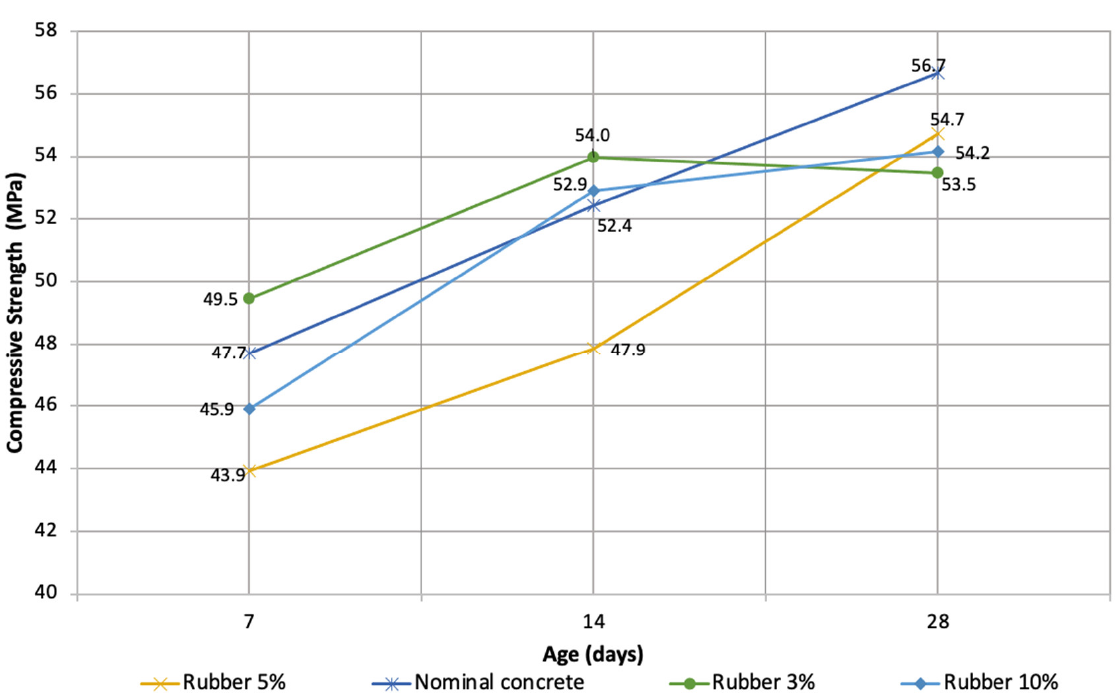
Figure 4. Compressive strength at the ages of 7, 14, and 28 days.